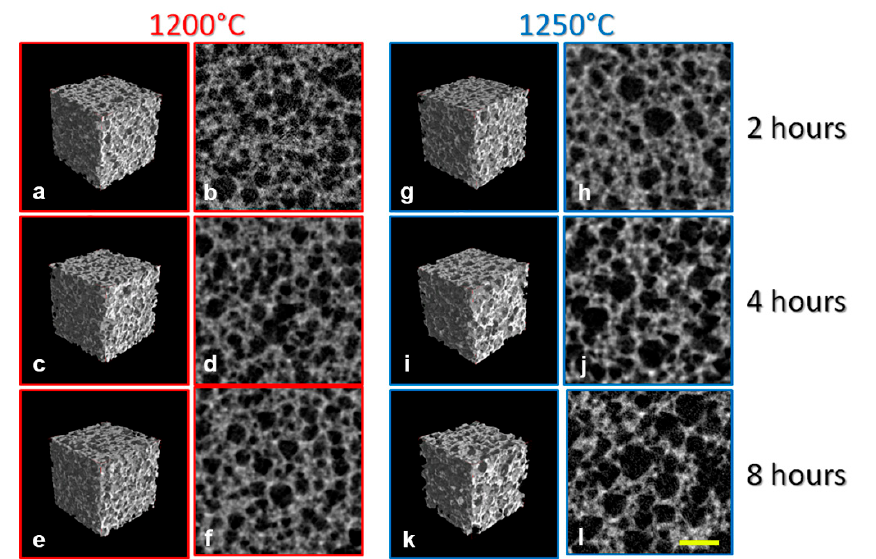
Figure 1. MicroCT analysis of the sintered biomaterials: ( a–f ) Samples sintered at the peak temperature of 1200 °C; ( g–l ) Samples sintered at the peak temperature of 1250 °C. 3D reconstructions ( a, c, e, g, i, k ) and axial ( b, d, f, j, l ) 2D sections before compressive loading; representative sample of: ( a, b ) T = 1200 °C@2 h group; ( c, d ) T = 1200°C@4 h group; ( e, f ) T = 1200 °C@8 h group; ( g, h ) T = 1250 °C@2 h group; ( i, j ) T = 1250 °C@4 h group; ( k, l ) T = 1250 °C@8 h group. Larger pores for samples sintered at T = 1250 °C with respect to those sintered at T = 1200 °C were found, independently from sintering time at the peak temperature. Yellow bar: 500 µm.